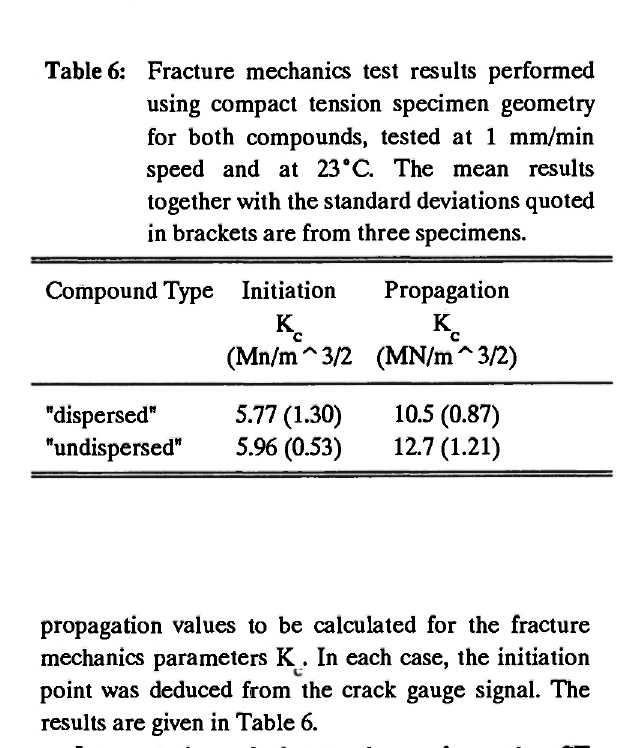
Table 6: Fracture mechanics test results performed using compact tension specimen geometry for both compounds, tested at 1 mm/min speed and at 23 "C. The mean